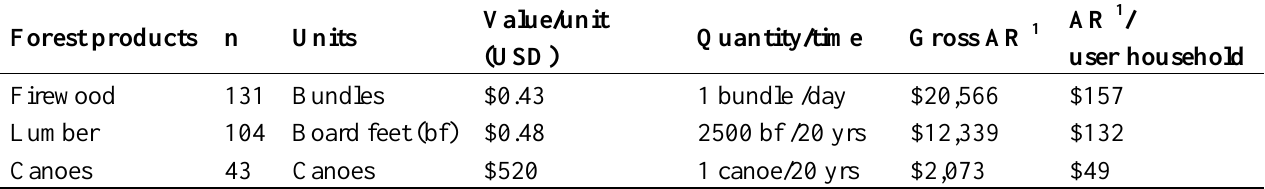
Table 2. Estimates of annual returns from forest product collection in Nueva Jerusalen.